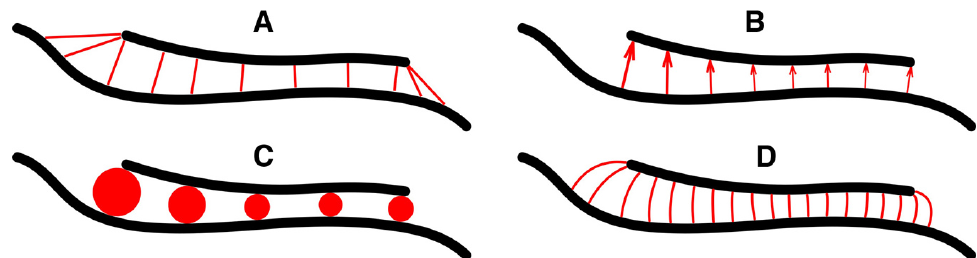
Figure 2: Schematic description of the four implemented methods, sagittal view. The lower bold black curved line depicts the surface of the tibial bone, the upper one the cartilage surface. Red elements explain the respective method. (A) Near- est neighbor. (B) Surface normals. (C) Local thickness. (D) Field